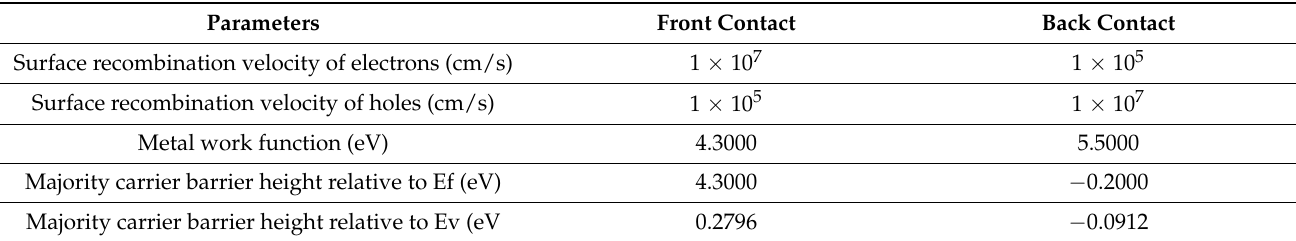
Table 2. Simulation parameters used for back and front contact.